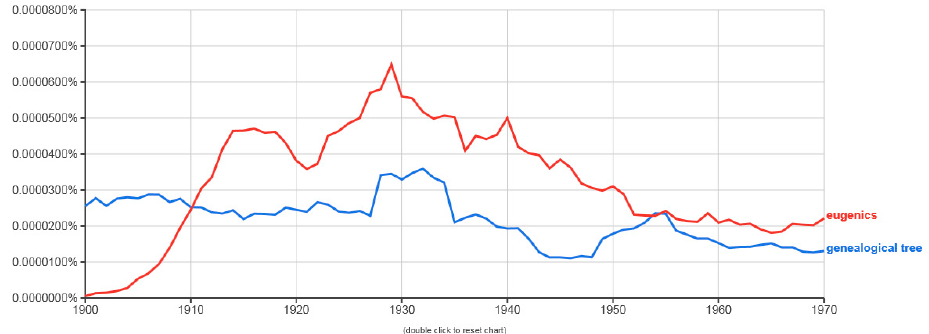
Figure 1. Trend in the use of ’eugenics’ and ‘genealogical tree’ in Google Ngrams. Note: The graph shows the frequency of these keywords in a given year as a proportion of the total number of words in the database for that year. Source: Google Ngrams for the years 1900–1970 from the corpus of books ‘British English (2009)’ (published in Great Britain in the English language), with a smoothing of 3. Generated via Google Ngram Viewer: https://books.google.com/ngrams. For additional technical information on the process of graphing Ngrams, see (Michel et al. 2010). Quantitative Analysis of Culture Using Millions of Digitized Books. Science. Supporting Online Material (Published 16 December 2010. DOI:10.1126/science.1199644/DC1).